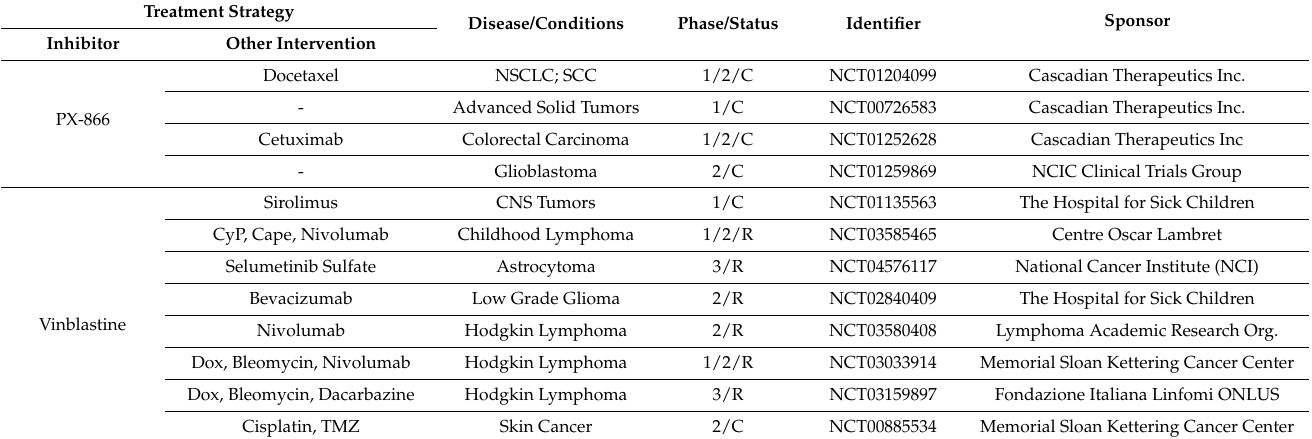
Table 2. Ongoing and completed clinical trials with natural products for the treatment of cancer (the structures of these products are shown in Table